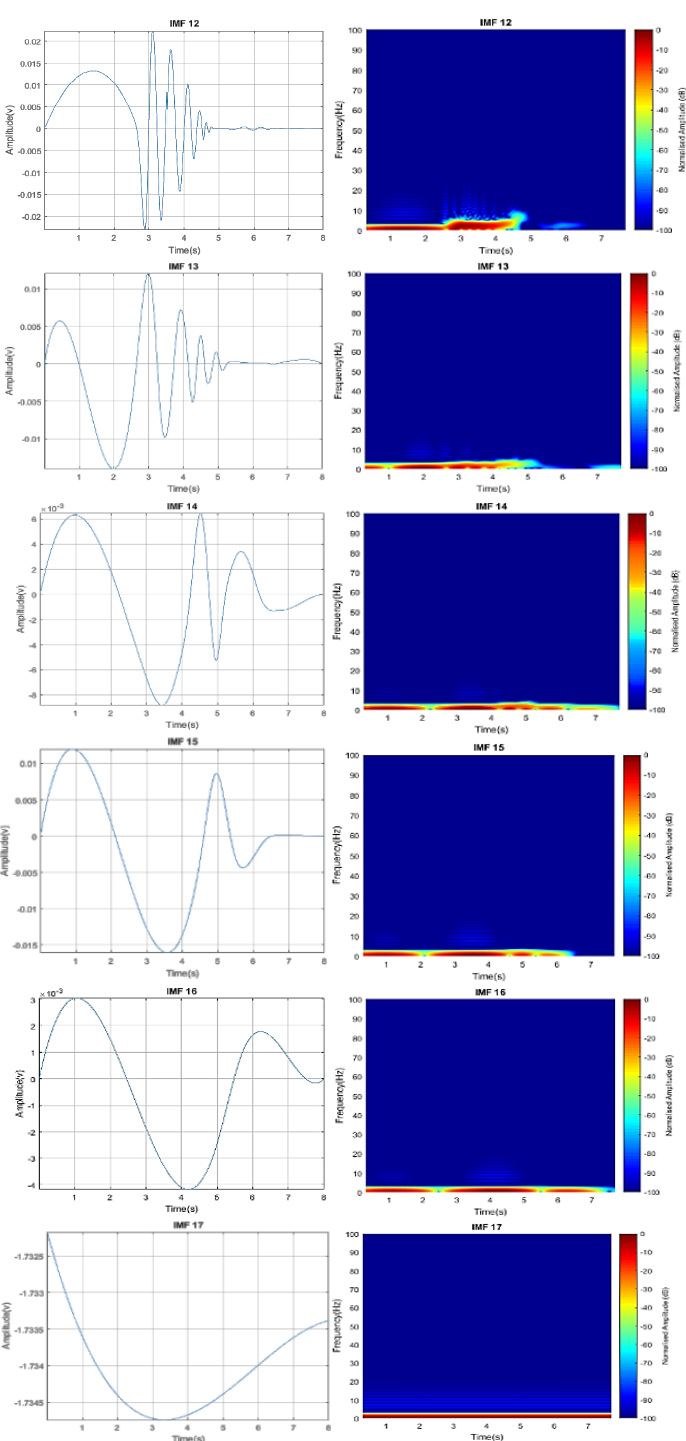
Figure 10. Time domain and STFT plot of IMF1-IMF17.